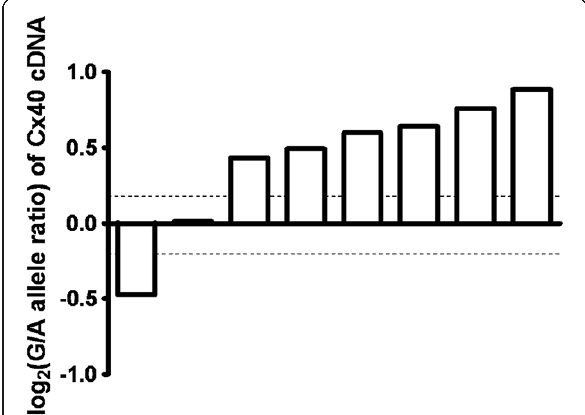
Figure 5 Allelic expression imbalance analysis of Cx40-A mRNA. Shown are eight atrial tissue samples heterozygous for the GJA5 3 0 UTR insertion/deletion polymorphism and the indicator SNP rs1043806. Each bar represents the allelic expression ratio for an individual subject, based on peak heights for cDNA/gDNA at the indicator SNP site. Significant allelic mRNA imbalance is found when the cDNA allelic ratio falls outside of a 95% confidence interval created by the gDNA allelic ratios (dotted lines). The G allele of the indicator SNP was always found together with the deletion allele of the insertion/deletion polymorphism. Six samples demonstrated weak allelic expression imbalance of Cx40 favoring the deletion-G allele. One sample was not significantly associated with allelic expression imbalance and another sample exhibited Cx40 expression imbalance in the opposite